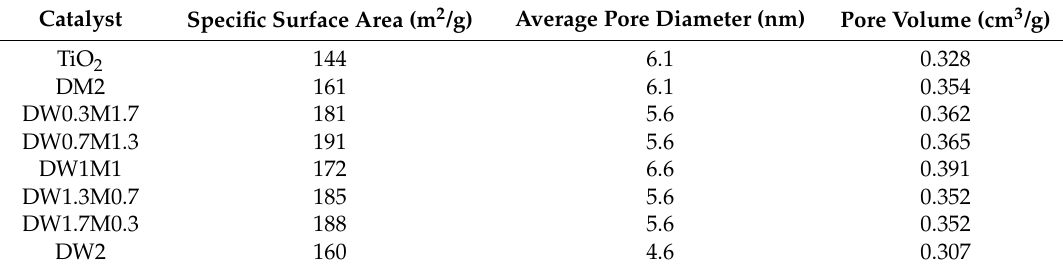
Figure 6. Pore size distributions of undoped, doped, and co-doped TiO 2 with different weight percentages of W and Mo ions. Table 2. Textural properties of TiO 2 , W-TiO 2 , Mo-TiO 2 , and W-Mo-TiO 2 catalysts.